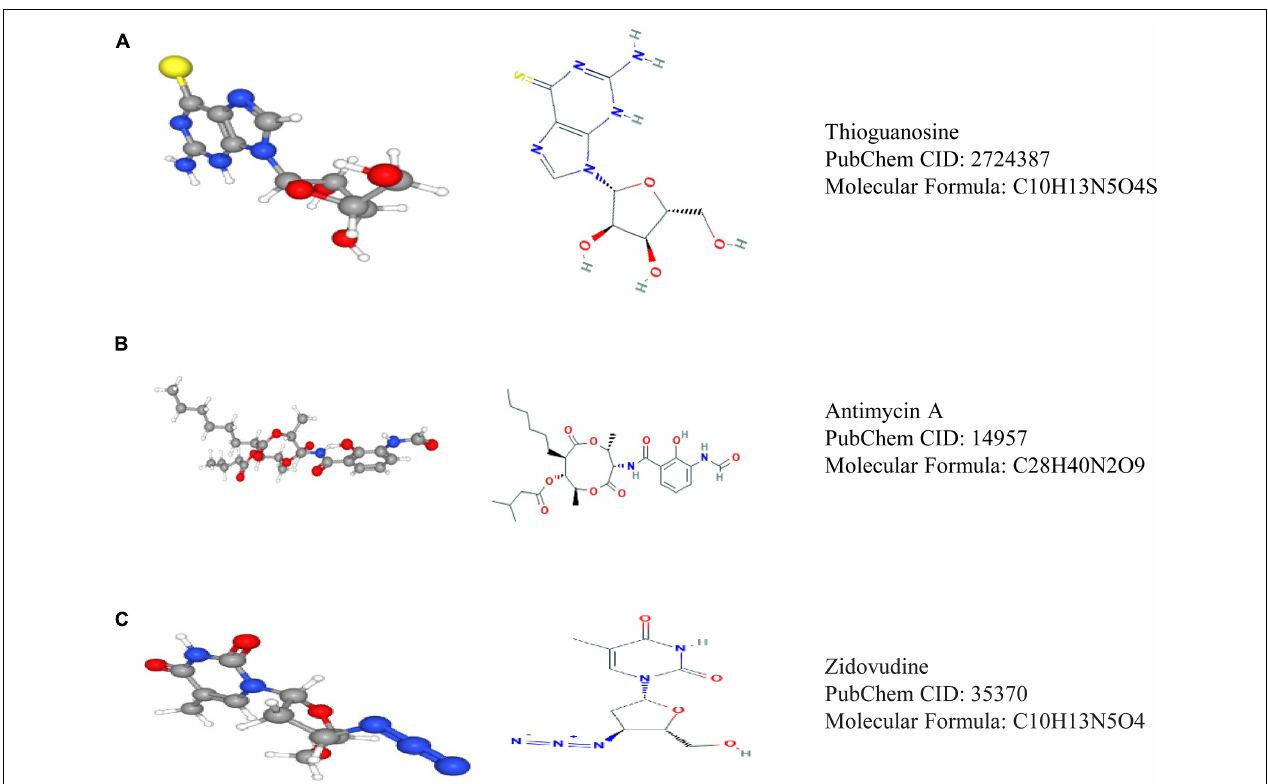
FIGURE 9 | Three drugs predicted by CMap analysis results. (A) Structure diagram of thioguanosine, structure formula, and ID. (B) Structure diagram of antimycin A, structure formula, and ID. (C) Structure diagram of zidovudine, structure formula, and